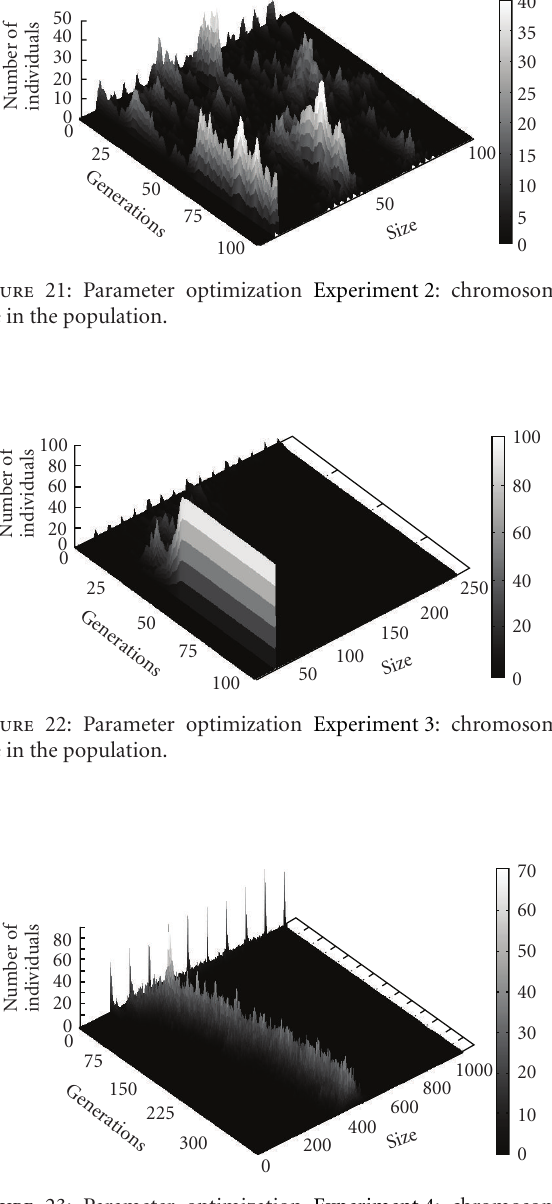
Figure 23: Parameter optimization Experiment 4: chromosome size in the population.